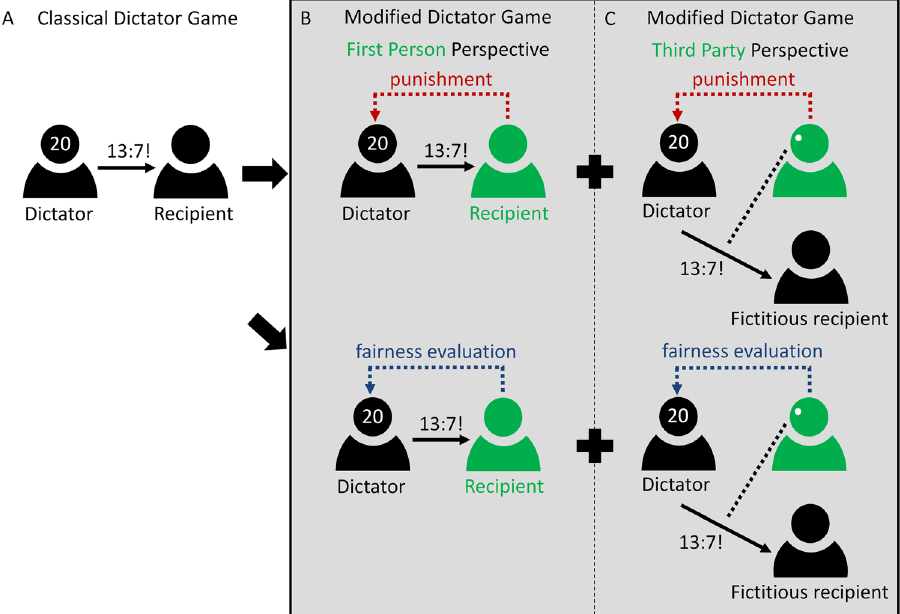
Figure 1. Illustration of different versions of the Dictator Game. ( A ) The classical Dictator Game. ( B ) and ( C ) Modified versions of the Dictator Game that were used in this study employing both a punishment option and a fairness evaluation from a first person perspective ( B ) and a third party perspective ( C ). Participants are symbolized in green. Solid arrows indicate dictator assignments, red dashed arrows indicate punitive acts, blue dashed arrows indicate fairness assessments.